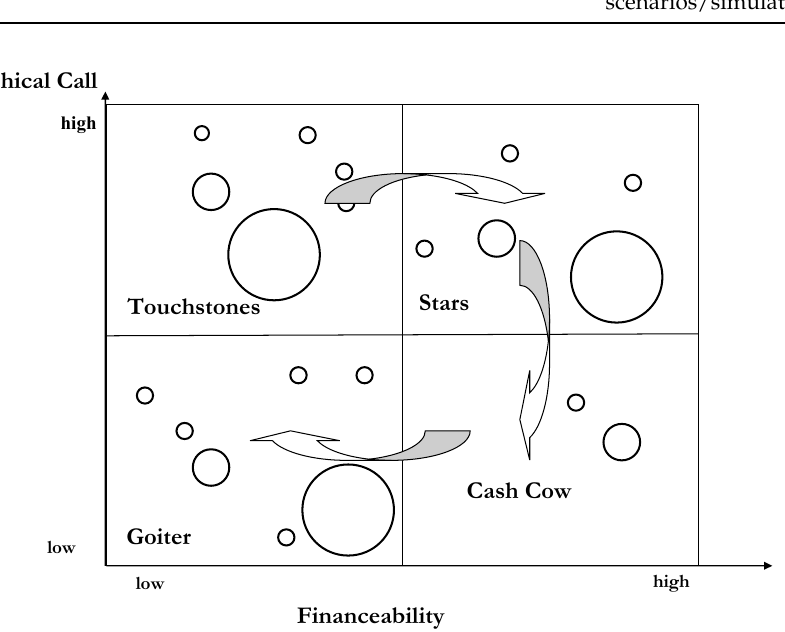
Figure 6. Portfolio Matrix of a non-profit organisation. Source: own, based on [22]. The balanced score card (BSC) can also be described as a causal loop diagram as it connects the different dimensions of strategic business performance [25]. While operational management frequently focusses on one performance dimension (usually profit), a BSC includes other dimensions (such as potentials, customer satisfaction, etc.) and shows their interdependencies. This approach reduces complexity and uncertainty by indicating the respective causalities of strategic